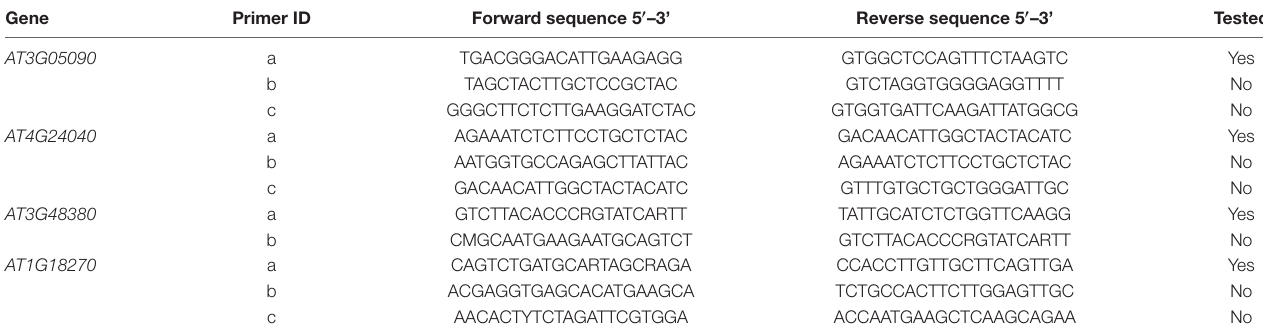
TABLE 1 | Nuclear primers designed on intron-flanking exons from selected genes. Gene Primer ID Forward sequence 5 (cid:48) –3’ Reverse sequence 5 (cid:48) –3’